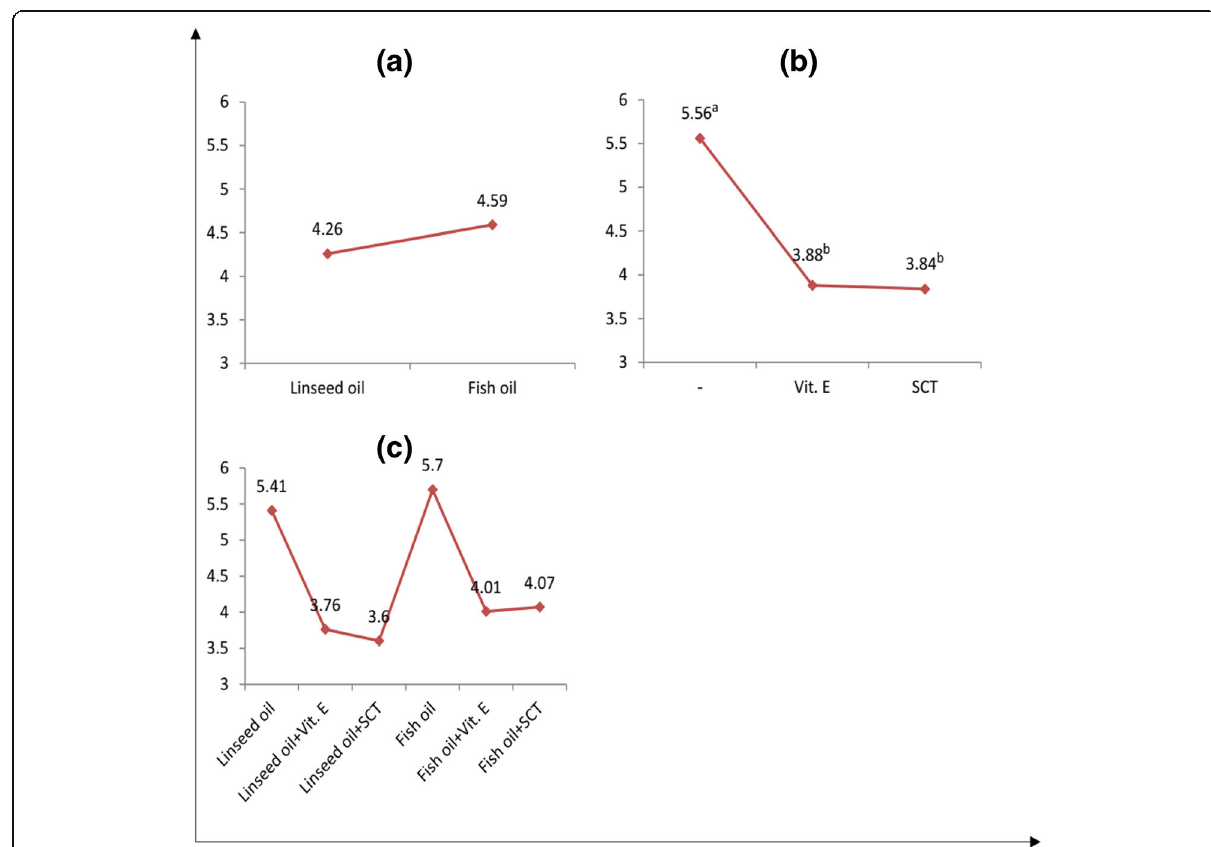
Fig. 1 Thiobarbituric-acid value of the meat of broilers fed diets containing different sources of oils and antioxidants. a Oil sources, b antioxidant sources, c interaction between oil and antioxidant sources. Superscript letters a and b indicate means within rows with no common superscripts differ significantly ( P <